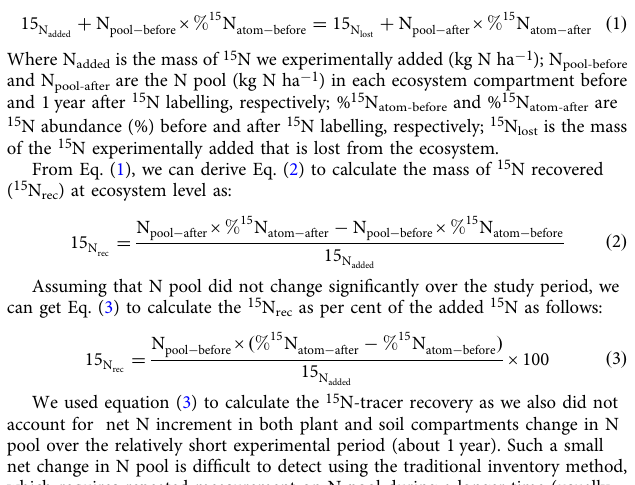
fi ndings imply future changes in the ratio of NH due to land use, technology, and policy changes will alter the retention pattern of deposited N and its potential contribution to C sinks in forest ecosystems.